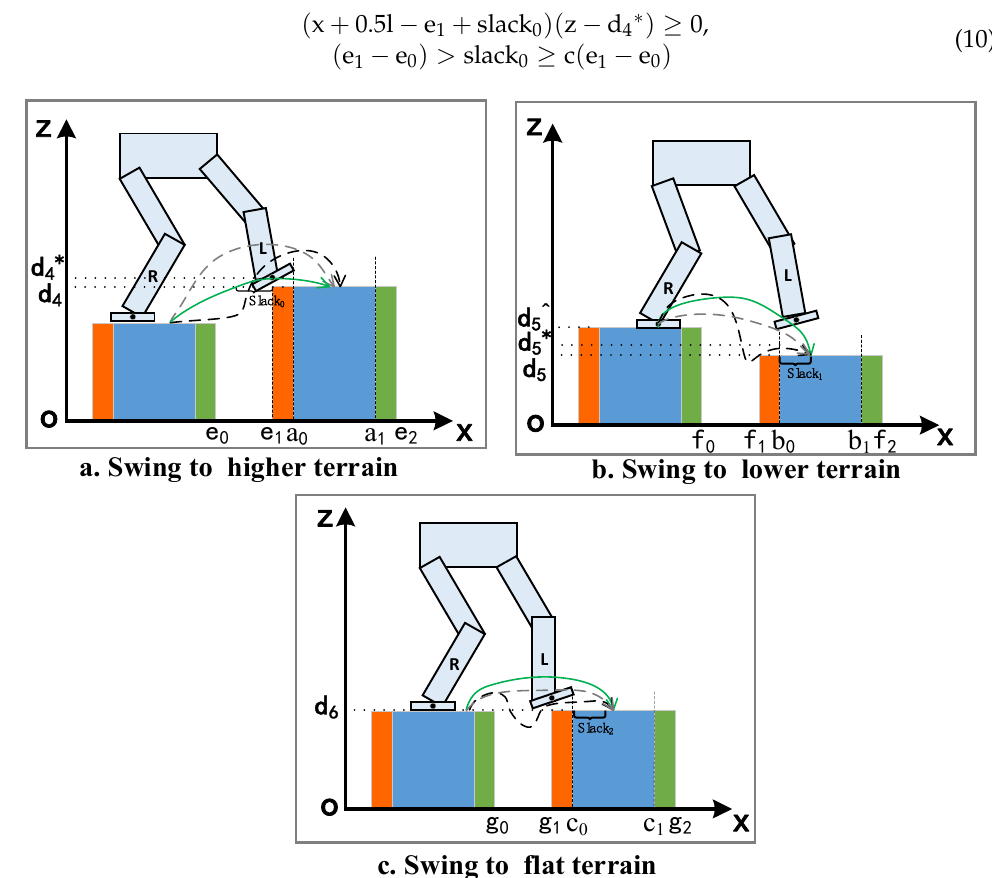
Figure 3. The swing foot movements of different terrain. d 4 , d 5 and d 6 are the height of terrain and d ∗ 4 , d ∗ 5 and d ∗ 6 are the corresponding safe height. d ˆ 5 is the height of supporting terrain. The green trajectories are the ideal movement and the gray and the black are the movements which should be avoided.